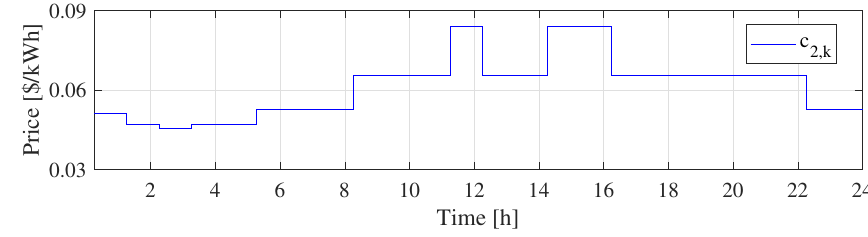
Figure 11. Energy price sequence c 2, k